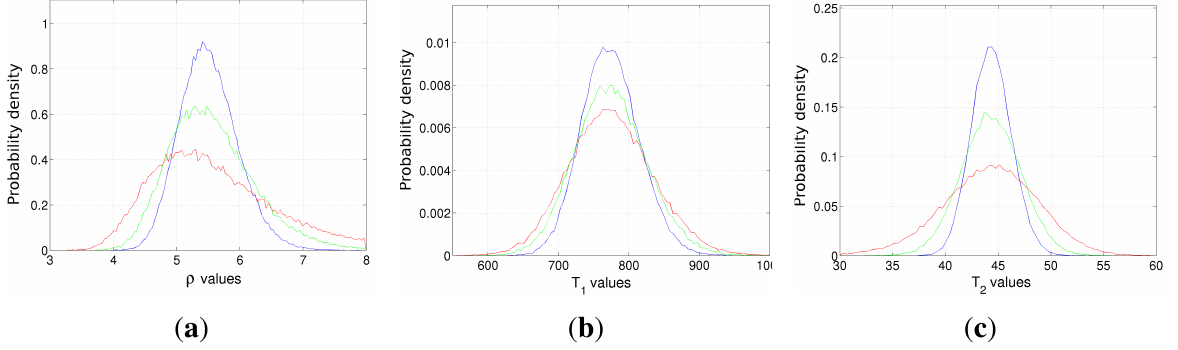
Figure 9. The empirical probability density function of the ρ ( a ), T in the case of Dataset 1 (blue line), Dataset 2 (green line) and Dataset 3 (red line). The true = 775 and T = 44 . 5 , values are ρ = 5 . 5 , T 1 2